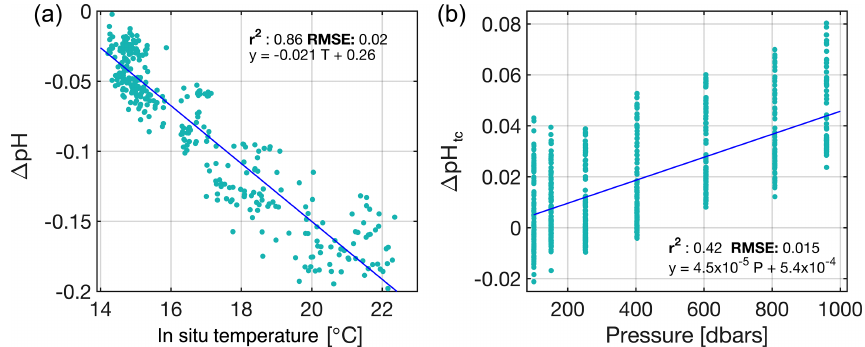
Figure 10. Linear regression fits are displayed for (a) (cid:49) pH (the difference between the mean pH s and pH g corrected for drift) vs. in situ temperature in the top 100m of the water column and (b) (cid:49) pH corrected for in situ temperature ( (cid:49) pH tc ) vs. pressure between 100 and 1000m using all available dives. The r 2 , root mean square error (RMSE), and the equation of the line are displayed for each linear fit.